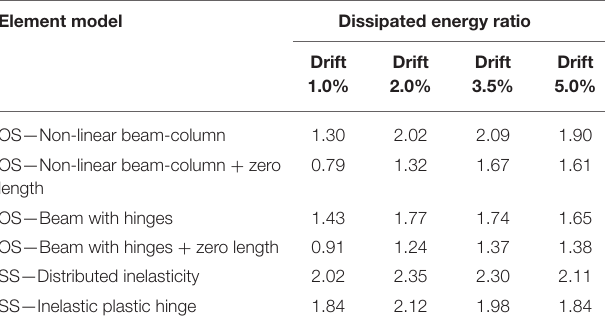
TABLE 3 | Experimental to numerical dissipated energy ratio for different drift levels of specimen